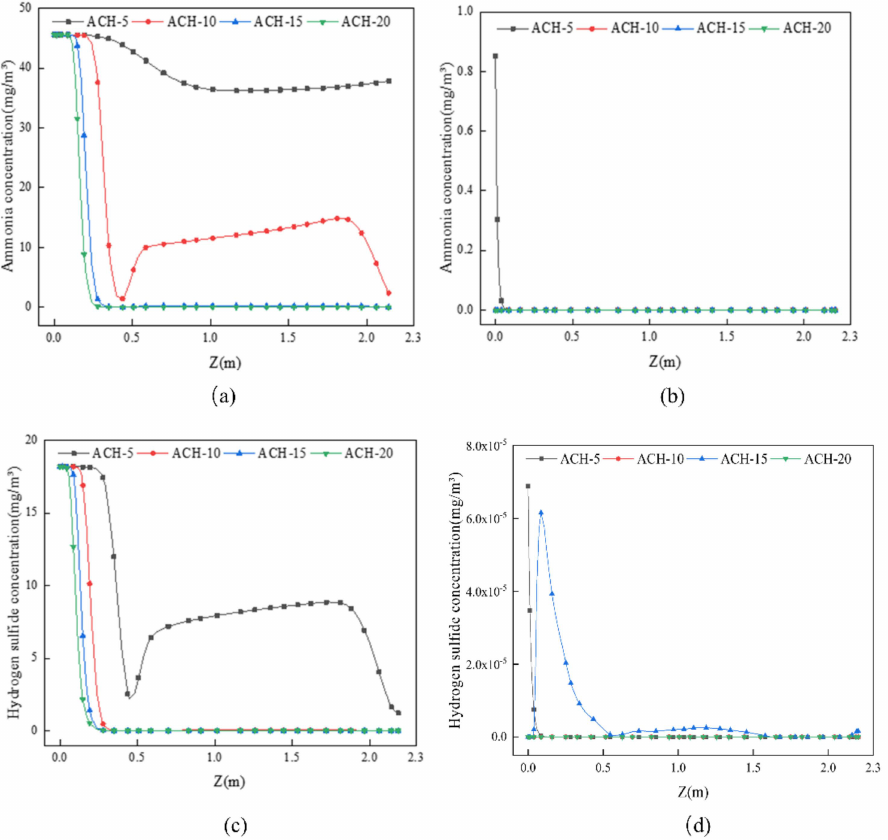
Figure 4. Contaminant concentrations along the vertical line at point E for different cases. Ammonia: ( a ): Case 1; ( b ): Case 2; Hydrogen sulfide: ( c ): Case 1; ( d ): Case